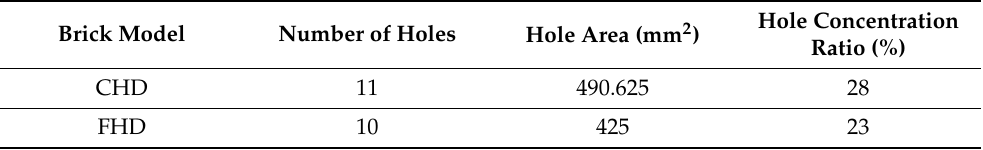
Table 6. Details of CHD and FHD brick models.